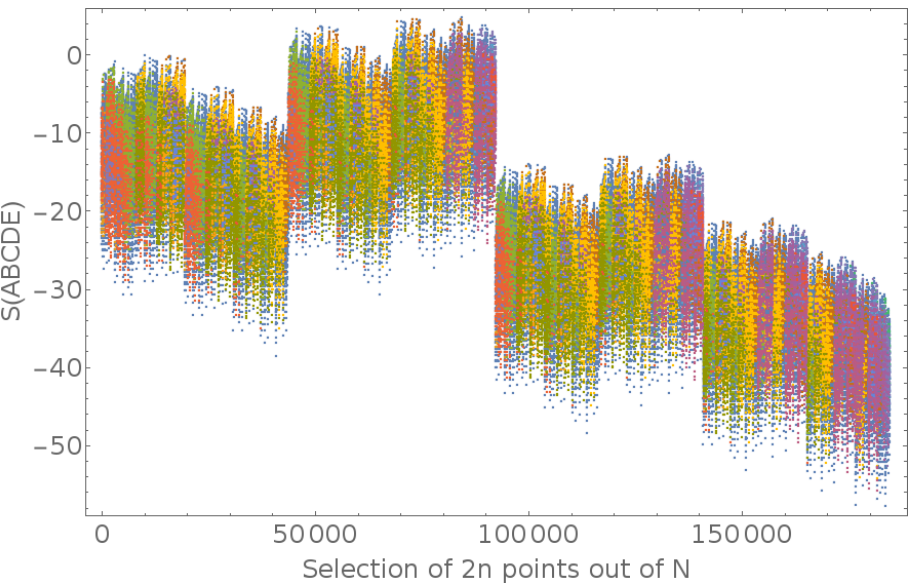
Figure 20 . Entanglement entropies for all 184756 possible unions of n = 5 non-adjacent intervals formed out of the N = 20 boundary points (6.24) at t = 1, for T L = 9 and T R = 1. The value of the entanglement entropy is dependent on the explicit cut-o(cid:11) or renormalisation scheme used, so the overall shift of the vertical axis is of no relevance, only linear combinations of entanglement entropies in which the cut-o(cid:11) dependence cancels are physical. The colour represents the di(cid:11)erent phases that the entanglement entropy of the union of (cid:12)ve intervals can be in. The intricate structure of the data over the horizontal axis is due to the lexicographic order in which the 184756 possible unions of n = 5 intervals are enumerated and the placement of the boundary points according to